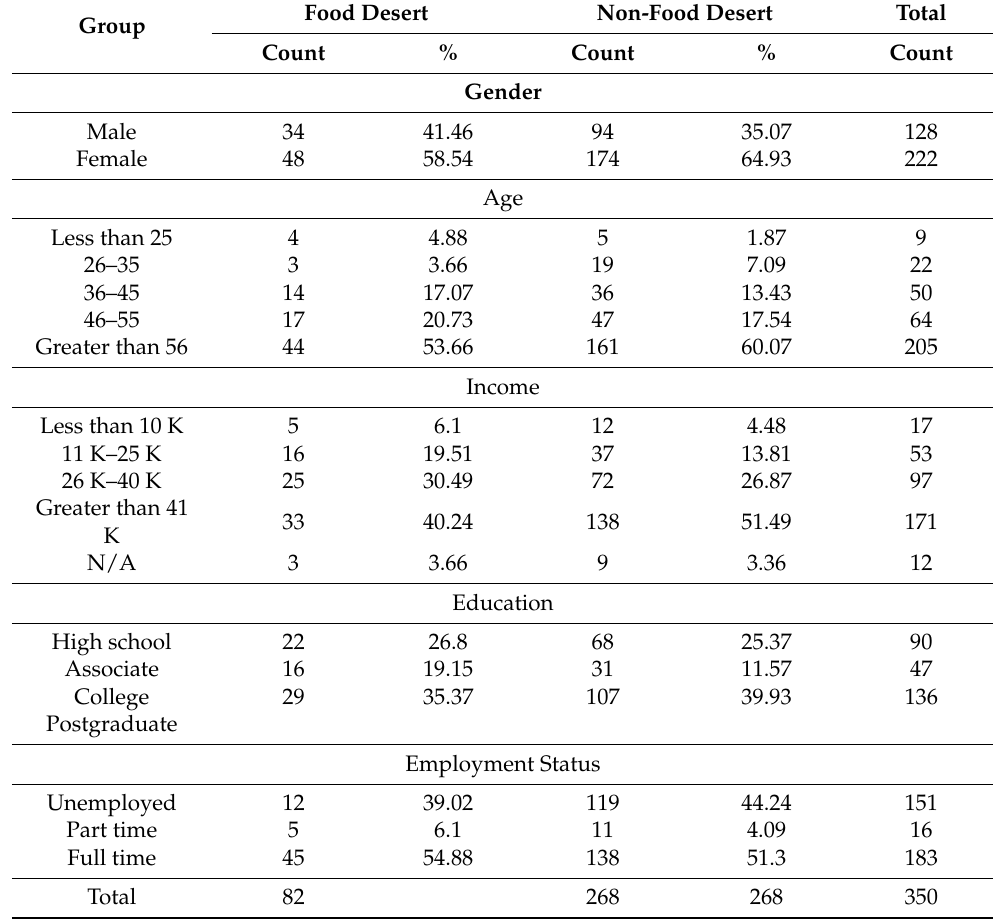
Table 7. The details of the number and percentage of demographic